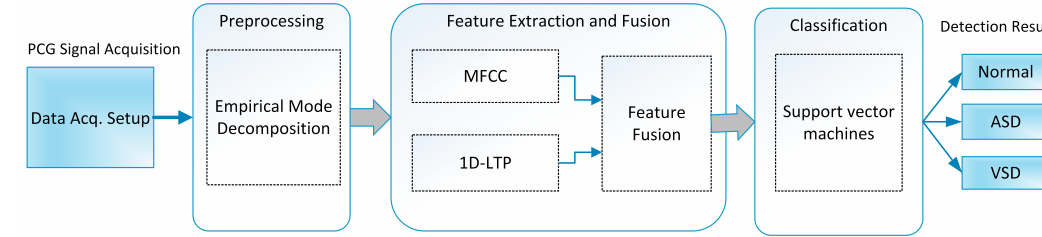
Figure 1. Sketch of the proposed cardiac disorder classification